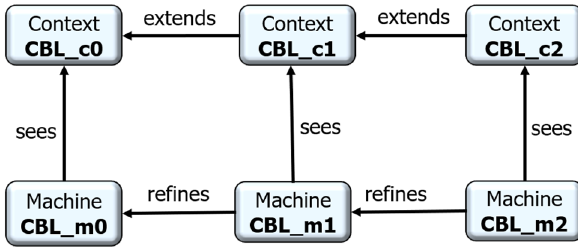
Figure 2. Architecture of the Event-B model for CCM4CBL.